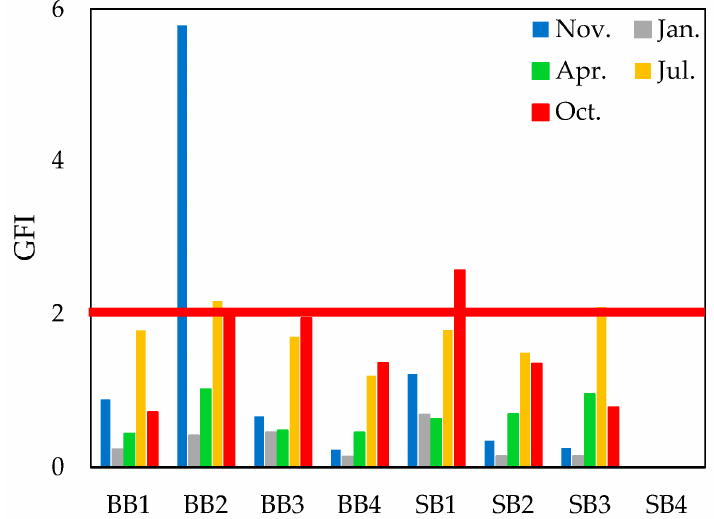
Figure 4. GFI for each sampled spring and sampling campaign (horizontal red line represents the value of GFI that indicates dominance of stygobite individuals).